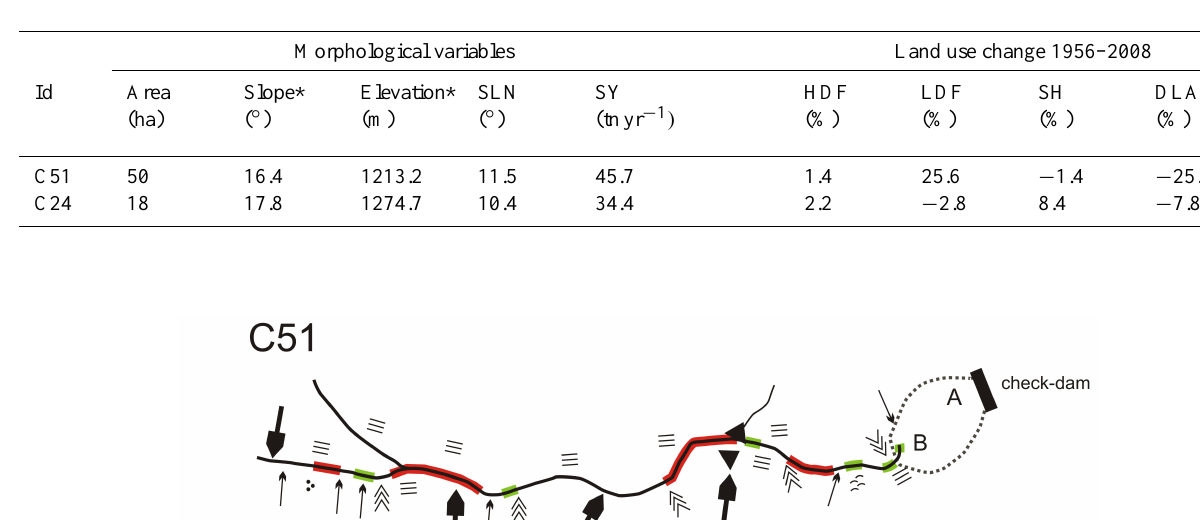
in sediments to the average parameter value computed from soils sampled in the drainage area (reference values from 0– 10 cm